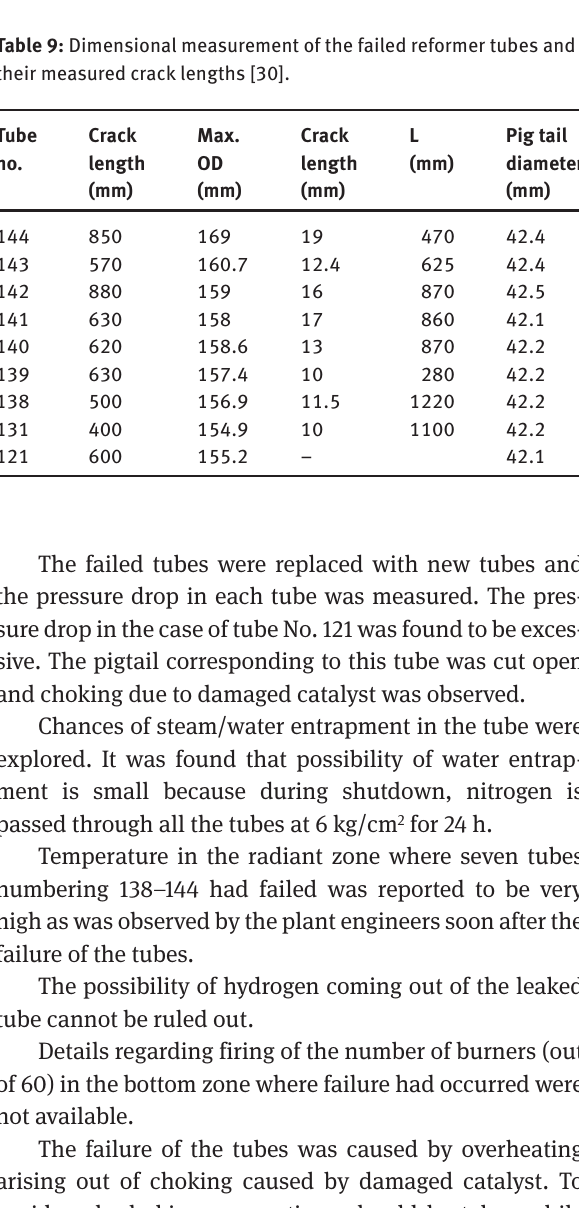
Fig. 13: Photograph of samples as received: (a) 144A, 144B, 121; (b) nine failed tubes